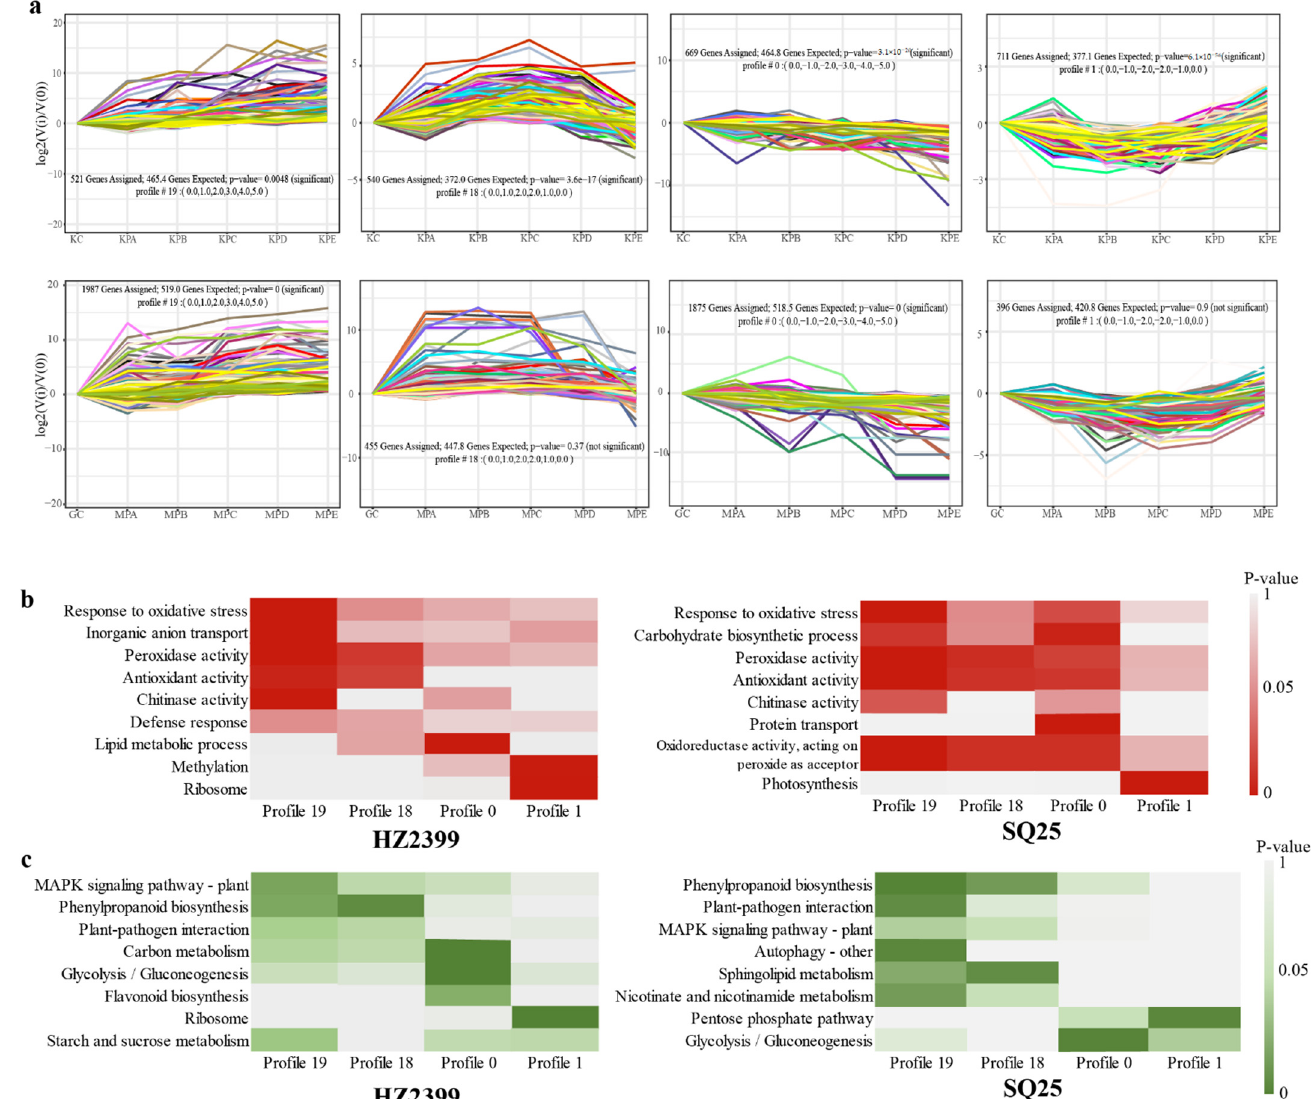
Figure 6. Gene expression patterns and enrichment of GO terms and KEGG pathways across six time points in HZ2399 and SQ25. ( a ) Gene expression patterns at six time points in HZ2399 and SQ25 predicted with STEM software. The number of genes and p -values for each pattern are indicated in the frame. ( b ) Results of the GO enrichment analysis of important processes in HZ2399 and SQ25. ( c ) Results of the KEGG pathway enrichment analysis of important processes in HZ2399 and SQ25. The p -value was used to indicate the significance of the most represented GO and KEGG Slim terms. Significant p -values are indicated in red or green, whereas nonsignificant p -values are indicated in light gray.